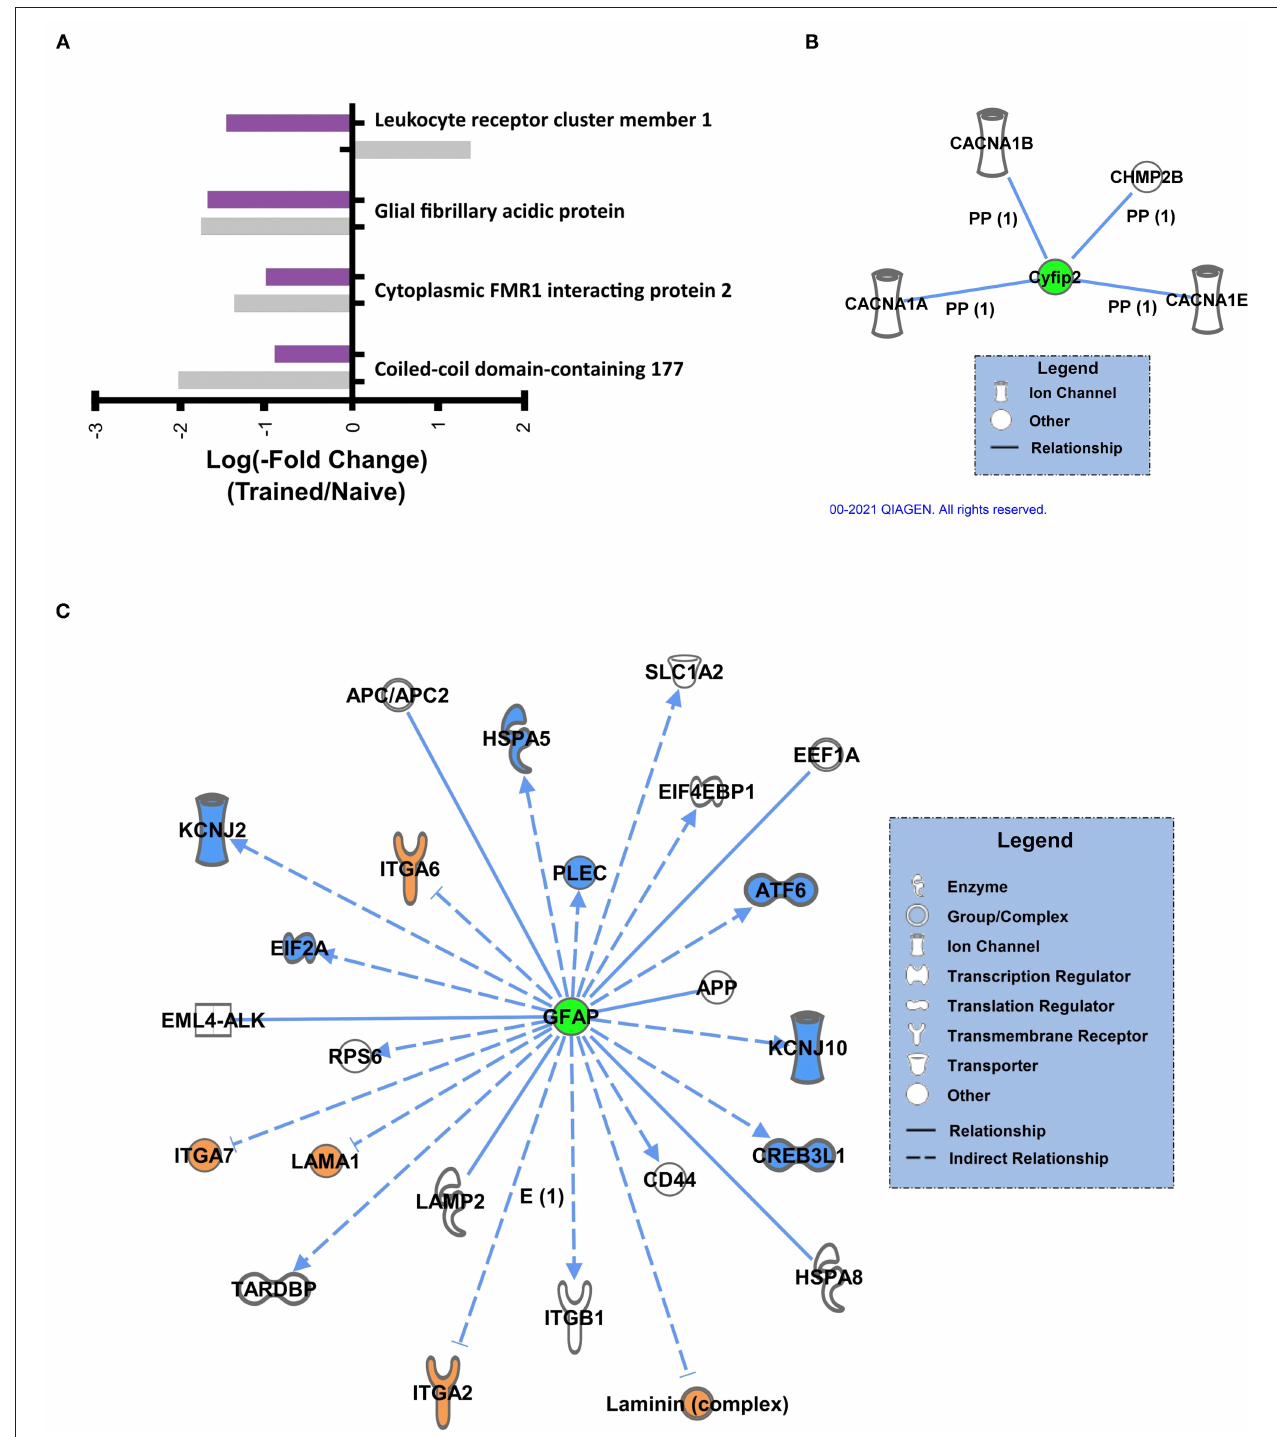
FIGURE 5 | Sex-independent K48 polyubiquitin targets in the amygdala during fear memory formation (A) Proteins found to be significantly altered in both female and male K48-purified samples following fear conditioning, with corresponding log value (-fold change). (B,C) Using IPA, the downstream proteins of Cyfip2 (B) and GFAP (C) were identified. Green denotes a decrease in protein abundance in the K48-purified samples, which reflects reduced protein expression levels and leads to decreased (shown in blue) or increased (shown in orange) function/levels of the effector protein. Direct relationships are shown with solid lines and the indirect relationship is indicated by a dotted